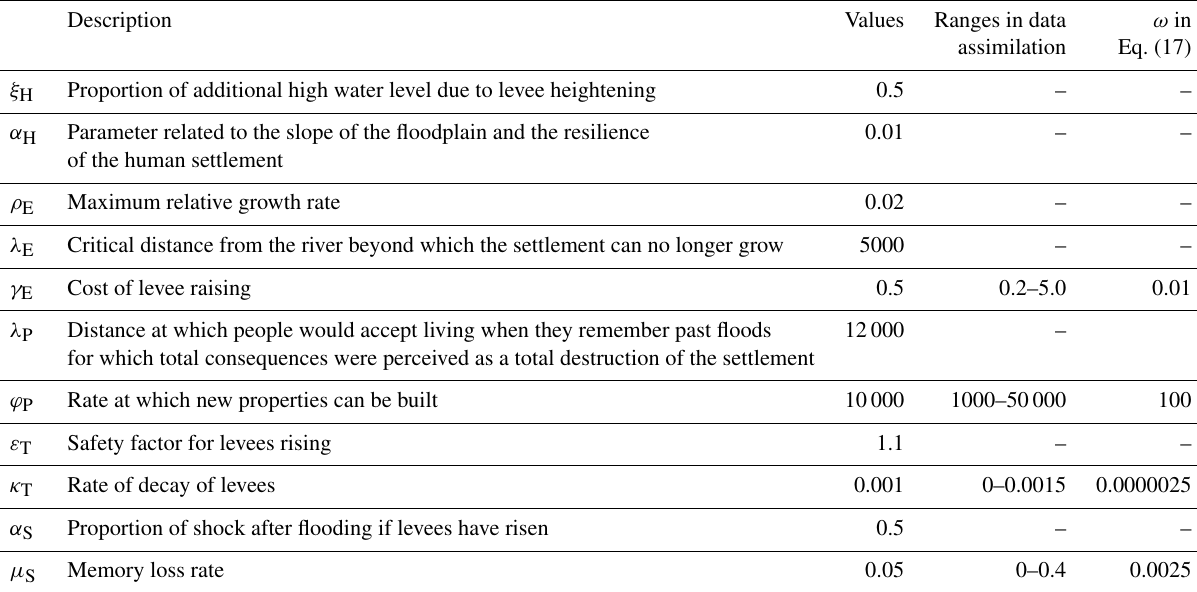
Table 1. Parameters of the flood risk model. Description Values Ranges in data ω in